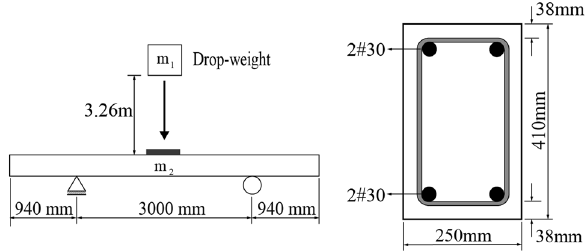
Fig. 11 Geometry of beams SS3a and SS3b (Saatci